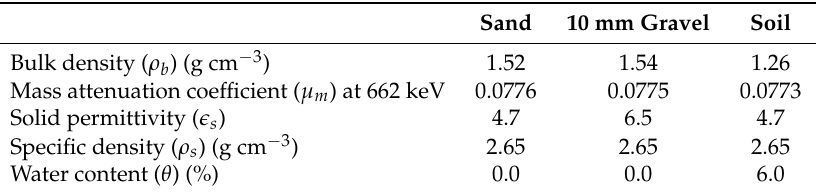
Table 1. Properties of the materials used in the